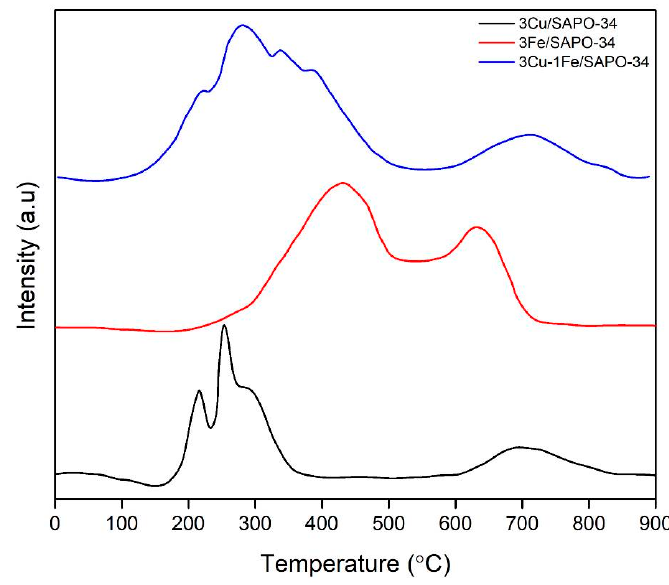
Figure 5. H 2 -TPR profiles of catalyst samples.